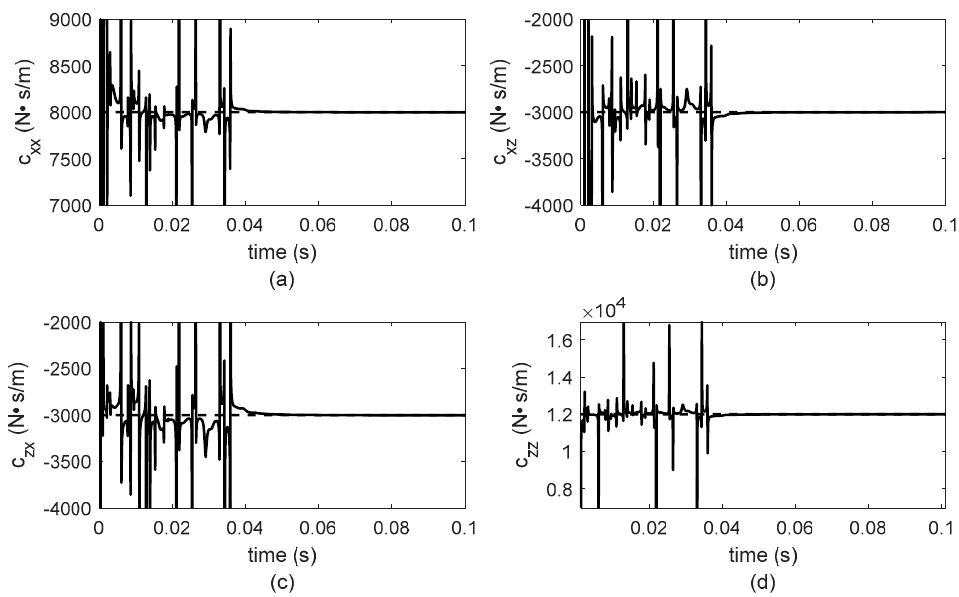
Figure 11. Identified damping parameters for bearing 1 with a linear ramp of excitation of 10 rad / s 2 . ( a ) (cid:1855) (cid:3051)(cid:3051) , ( b ) (cid:1855) (cid:3051)(cid:3053) , ( c ) (cid:1855) (cid:3053)(cid:3051) , ( d ) (cid:1855) (cid:3053)(cid:3053) .